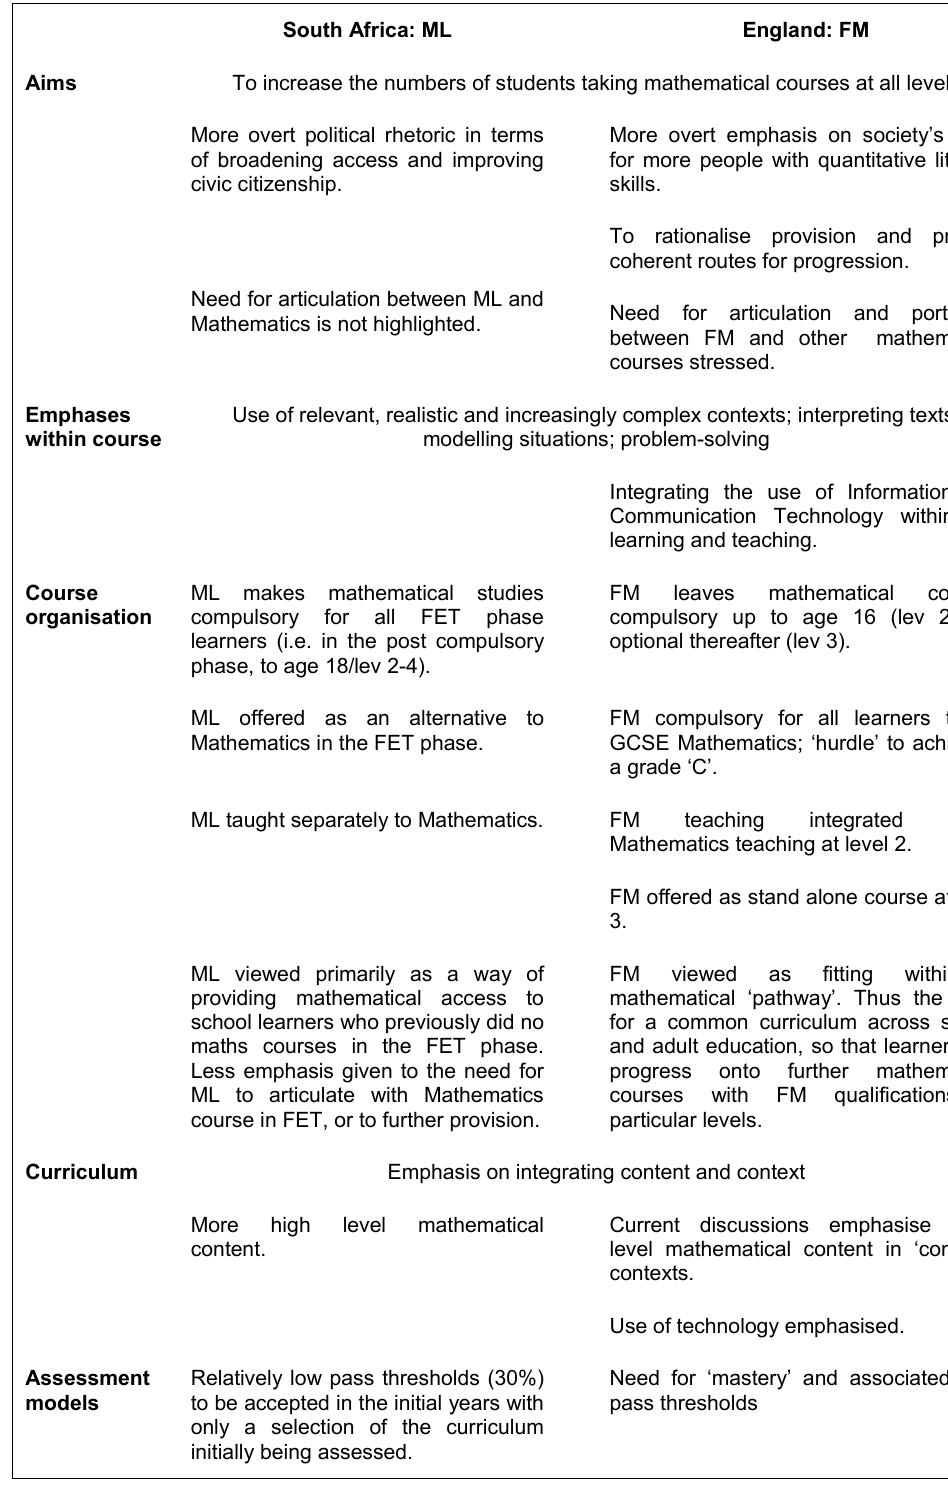
Table 2 : Summary of overlaps and contrasts in South Africa’s Mathematical Literacy and England’s Functional